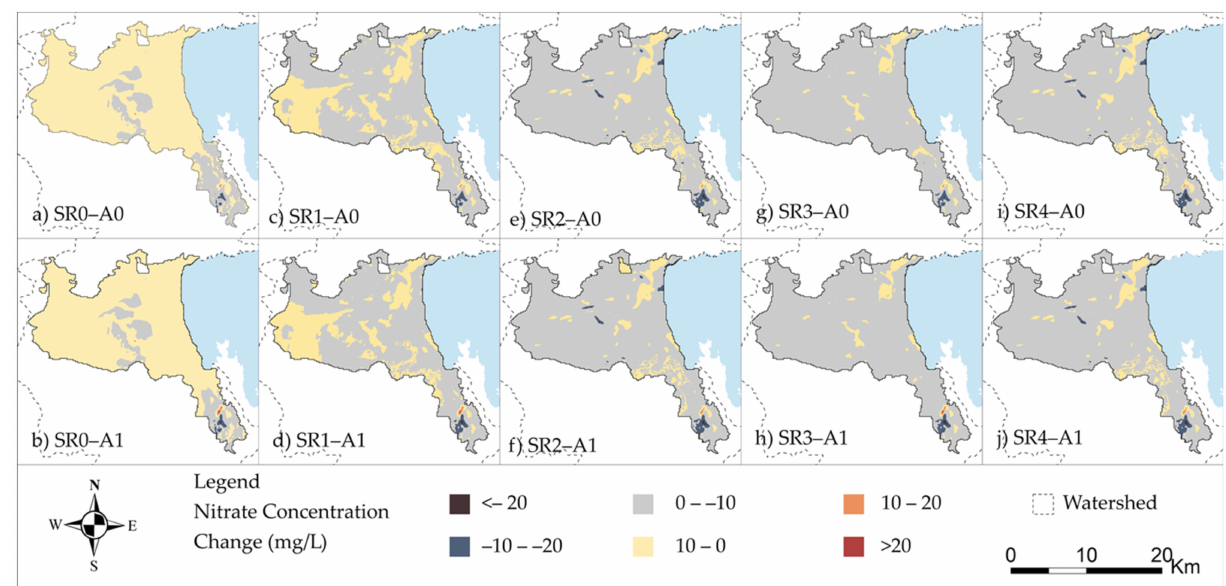
Figure 8. Nitrates concentration (NO 3 − ) change in (mg/L) of Almyros aquifer at the end of the simu- lation period (September 2018) between the baseline scenario (S0) and the various water resources and fertilization scenarios. ( a ) S0—(SR0-A0), ( b ) S0—(SR0-A1), ( c ) S0—(SR1-A0), ( d ) S0—(SR1- A1), ( e ) S0—(SR2-A0), ( f ) S0—(SR2-A1), ( g ) S0—(SR3-A0), ( h ) S0—(SR1-A1), ( i ) S0—(SR4-A0), and ( j )